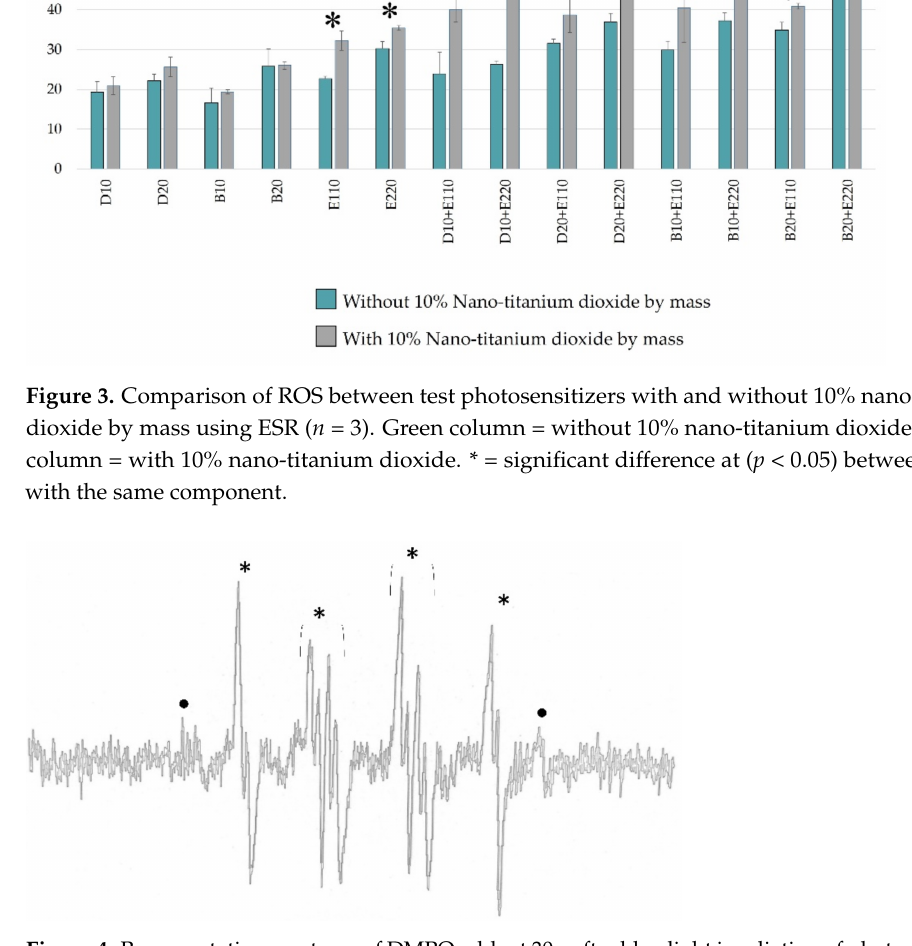
Figure 4. Representative spectrum of DMPO adduct 30 s after blue light irradiation of